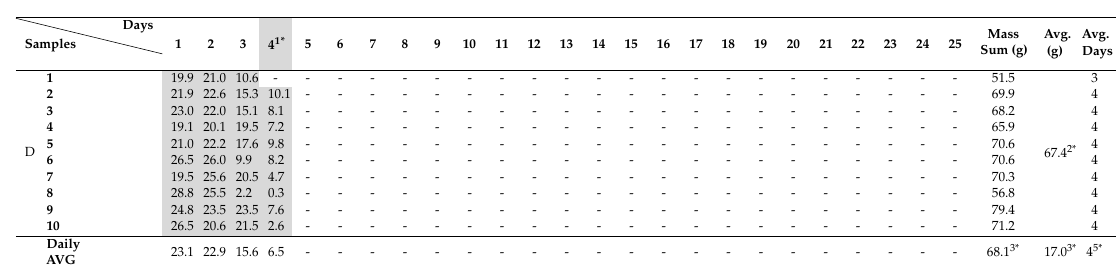
Table 8. Oil leakage mass measurement result (specimen D).